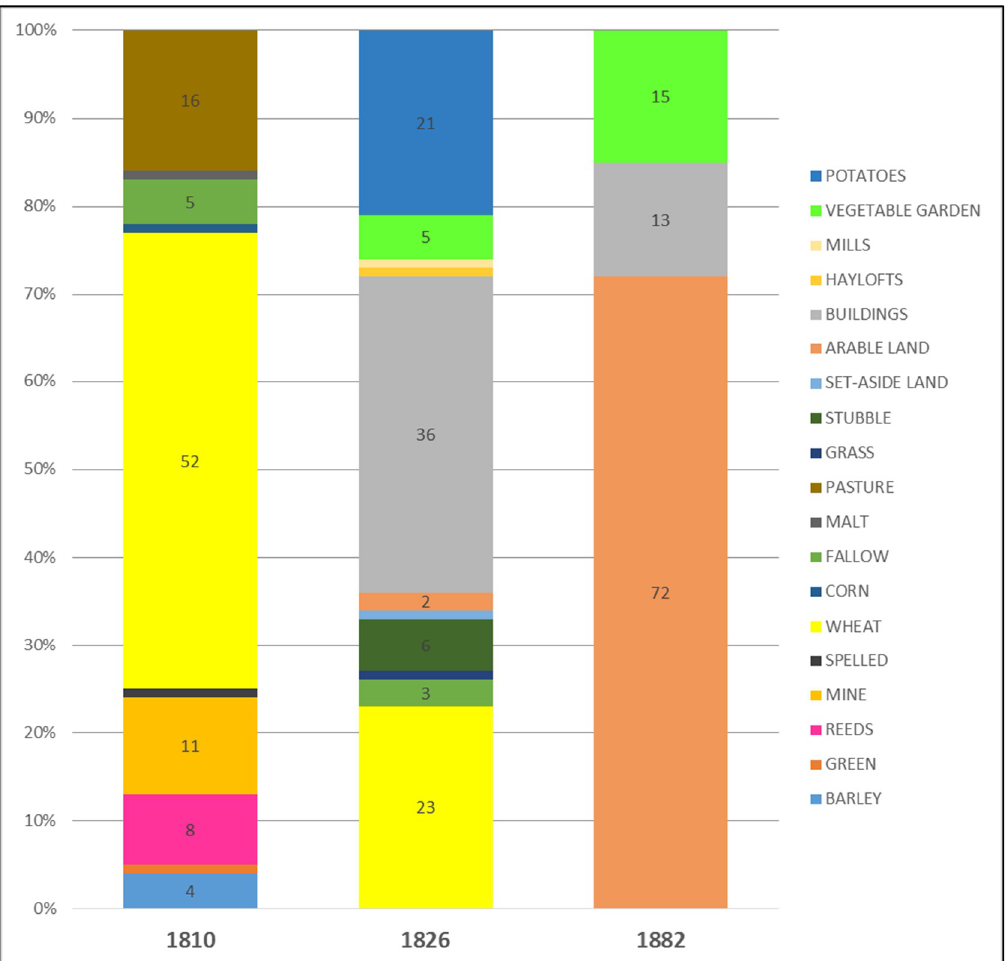
Figure 6. Castel di Sangro‑Lucera occupations land use in the territory of Pescolanciano. Source: Castel di Sangro-Lucera occupations land use in the territory of National Archives of Foggia Source: National Archives of Foggia, Atlases 2, 39, 121.